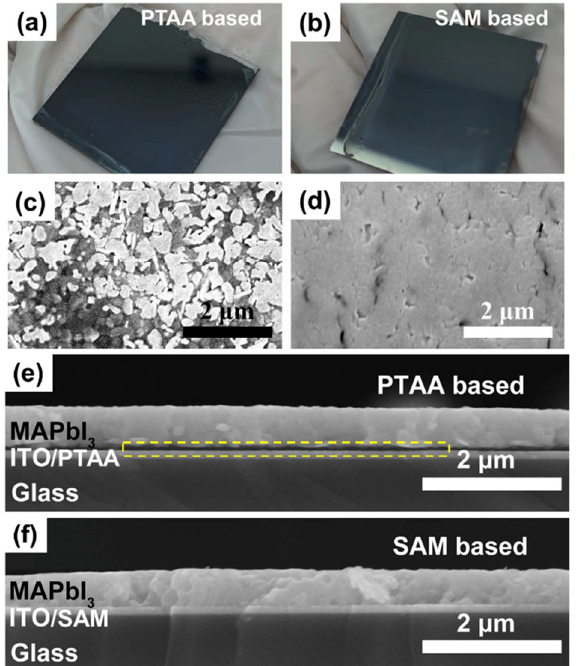
Figure 2 Photography of blade-coated perovskite films on (a) PTAA- based substrate, and (b) SAM-based substrate. SEM images of the buried interface of perovskite films grown on (c) PTAA-based substrate, and (d) SAM-based substrate. Cross-section SEM images of perovskite films blade-coated on (e) PTAA-based substrate, and (f) SAM-based substrate. The yellow rectangle indicates the gap between perovskite film and substrate. facilitate the perovskite nucleation at the initial stage of the blade-coating, forming dense perovskite nuclei on its surface. Then at the perovskite growth stage, the intermediate phase can form dense crystals in both vertical and horizontal directions, ensuring the adhesion of perovskite films on SAM-based substrates as illustrated in Fig. 3(d). In addition to the above-mentioned mechanism, we speculate that the methoxy headgroups of the MeO-2PACz SAM molecules pointing to the perovskite layer may form coordination bonds with lead ions (Fig. S2 in the ESM), which further